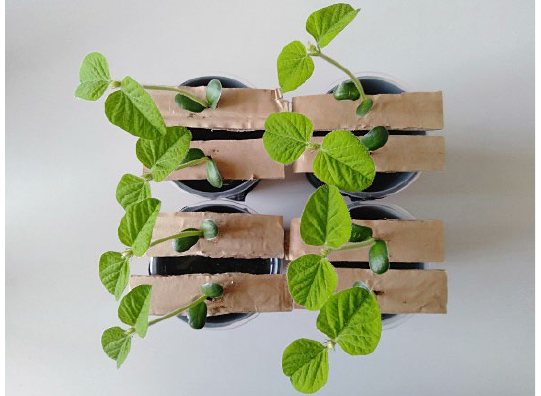
Figure 1. Soybean seedling culture